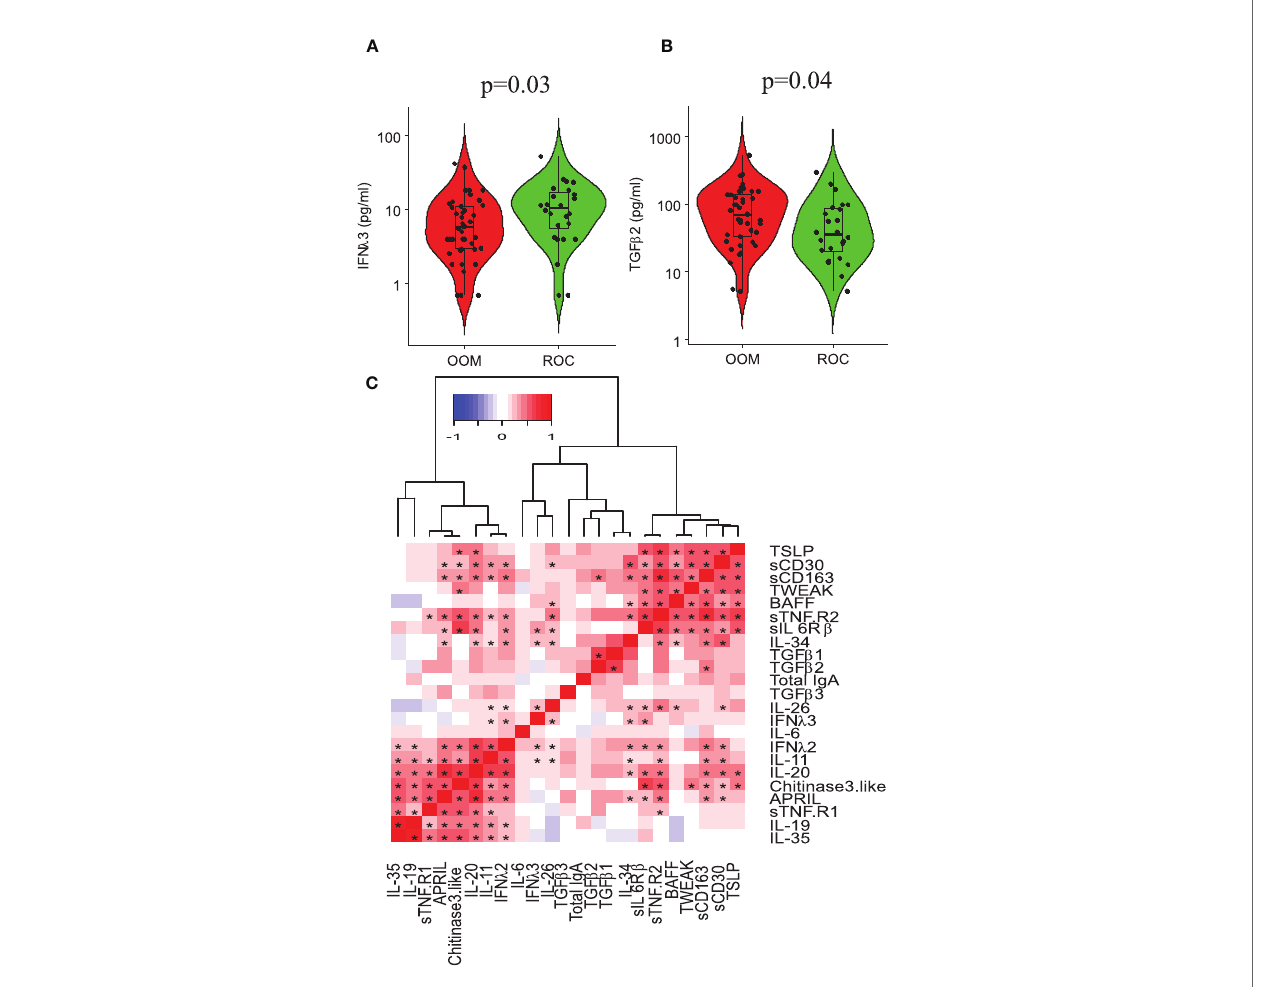
FIGURE 4 | Cytokine pro fi ling of human milk and its association with total IgA levels. Distributions of (A) IL-6 ( p = 0.02, 0.05 by Wilcoxon signed-rank test) and (B) TGF- b 2 ( p = 0.05) in OOM and ROC population shown on logarithmic scale to the base 10. (C) Hierarchial cluster analysis showing correlation between a panel of cytokines. Asterisk, adjusting for mother ’ s atopy in multivariate